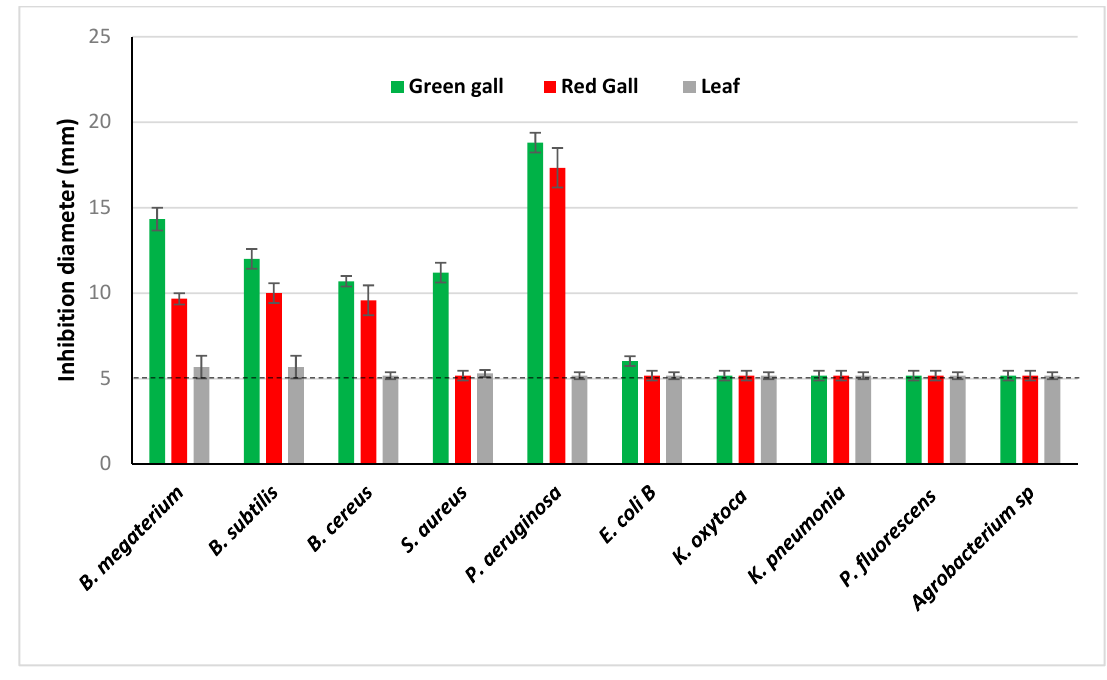
Figure 4. Agar-disk diffusion assay. Note that 5 mm means no inhibition. Bars are average of triplicates and error bars present one SD. Dashed line present limit of inhibition. Bars are average of 3 repeats (galls) or 6 repeats (leaves). Error bars are one SE. Dashed line is limit of no-inhibition. Bacteria are: Bacillus megaterium , B. subtillis , B. cereus , Staphylococcus aureus , Escherichia coli , Klebsiella